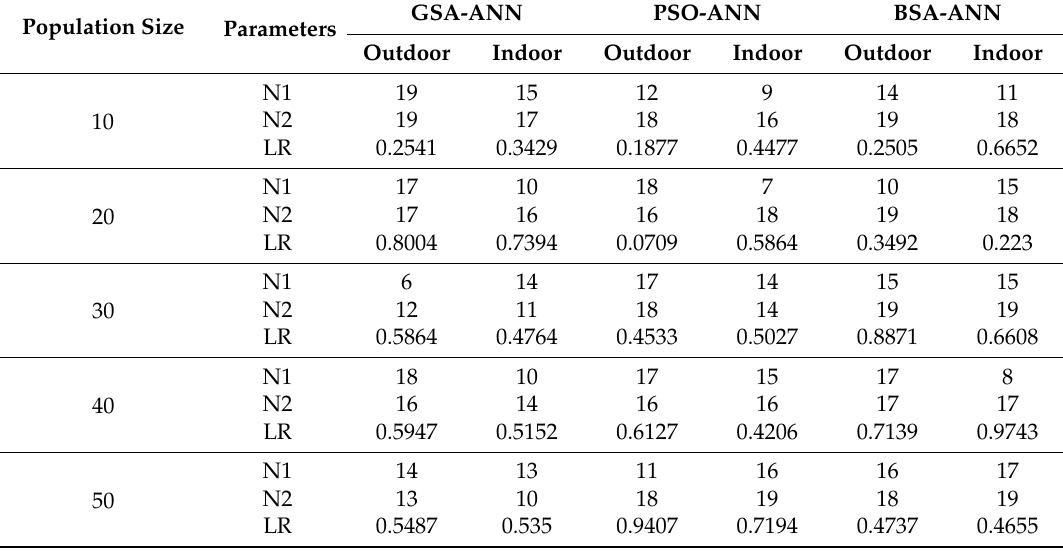
Table 3. Neurons in each hidden layer and learning rate of ANN based on heuristic algorithms for different population sizes.